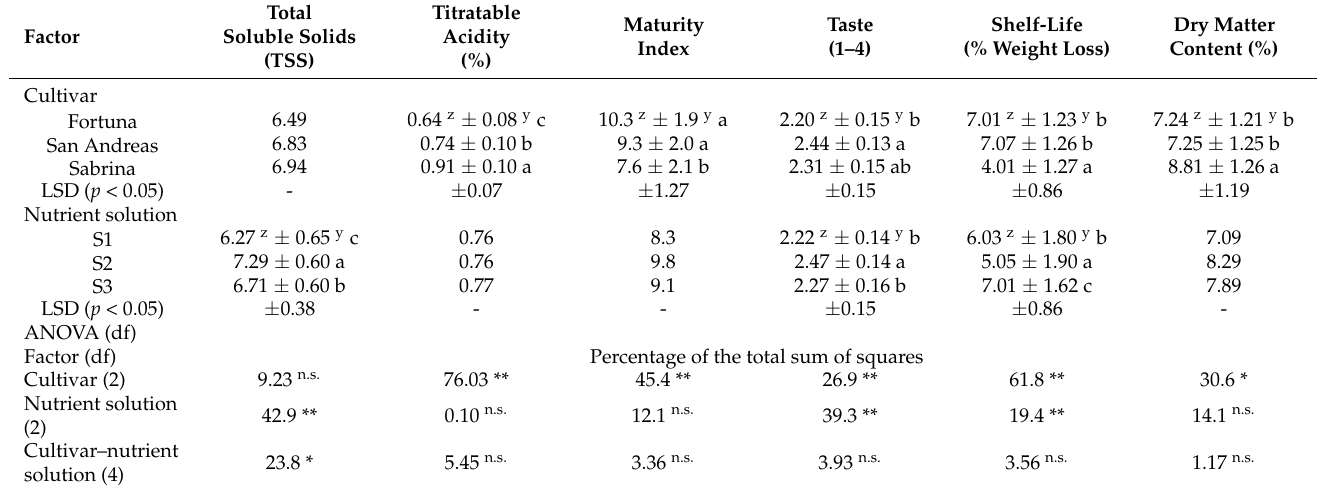
Table 4. Mean values, standard error ( ± ) and analysis of variance for quality parameters (total soluble solids, titratable acidity, maturity index, taste, shelf-life and dry matter content) of three strawberry cultivars (Fortuna, San Andreas and Sabrina) irrigated with three nutrient